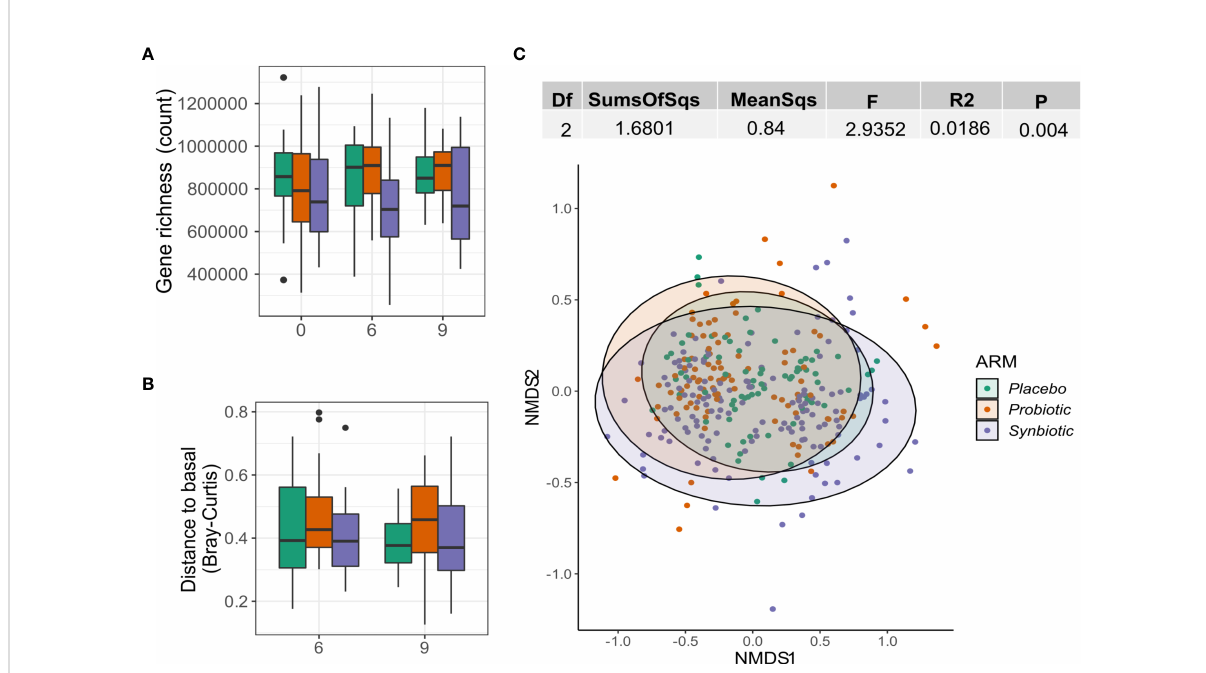
FIGURE 3 Effect of probiotics on the gut microbiome. (A) Gene richness counts for each intervention arm and month. Comparisons between group at each timepoint were performed using Wilcoxon test, while the paired version was used for within-group comparisons between months. (B) Distribution of Bray Curtis-Distances from baseline for each month and intervention arm. (C) NMDS showing sample ordination according to Bray-Curtis distance. Group distance dissimilarity was tested using